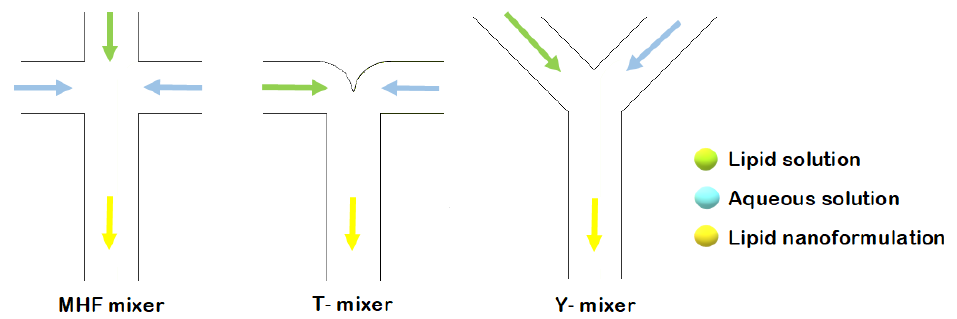
Figure 1. Schematic representation of liposome formation by MHF, and through T- and Y-shaped mixers.